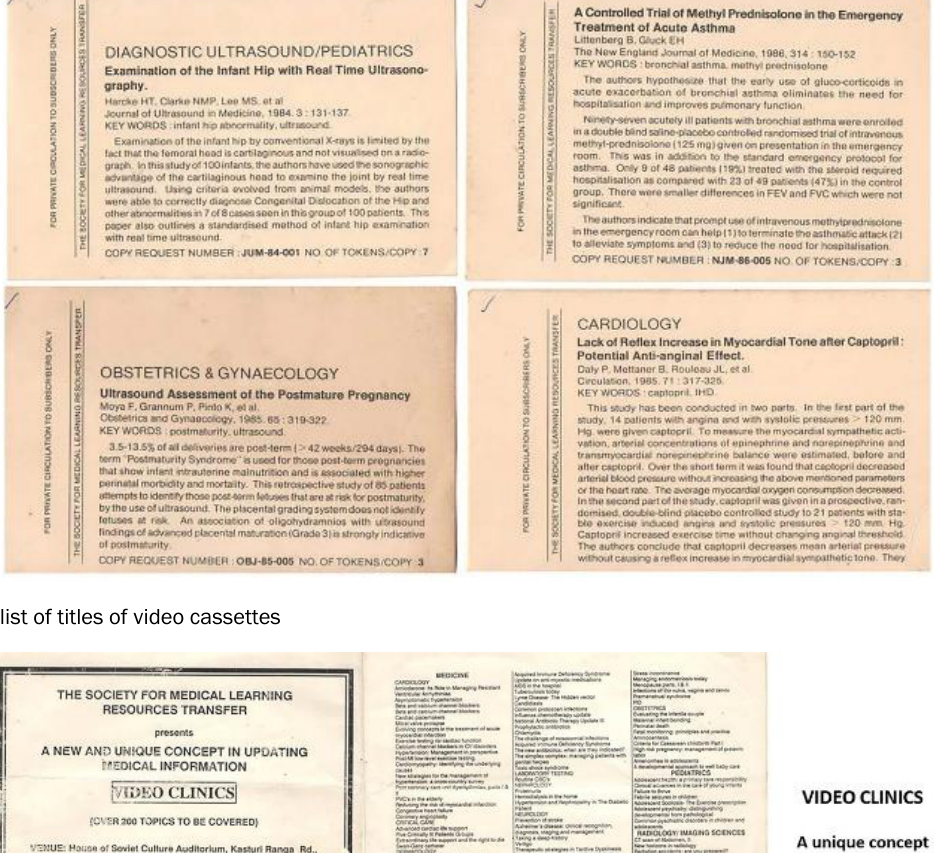
Figure 2 Illustrations of 13 x 8 cm index cards containing abstracts